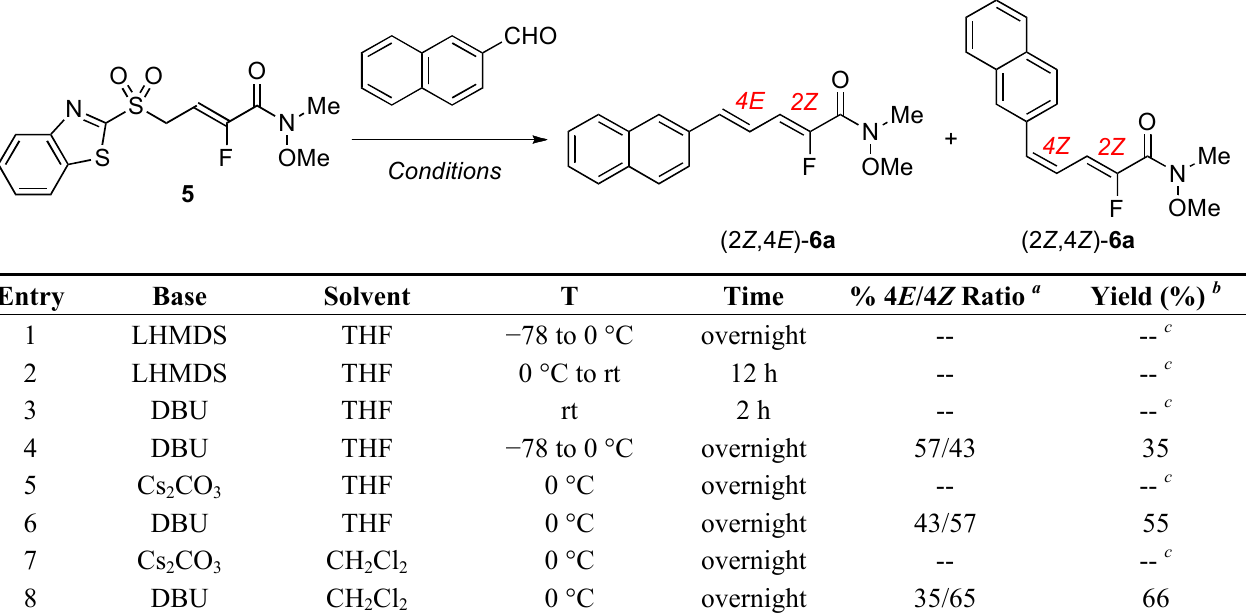
Table 3. Conditions tested for olefination reactions using the second generation Julia-Kocienski reagent 5 and 2-naphthaldehyde.